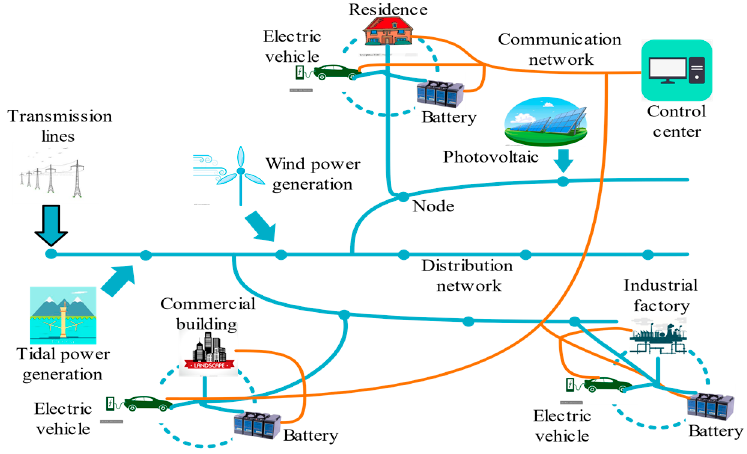
Figure 1. Battery energy storage systems (BESS) coordination control architecture model.